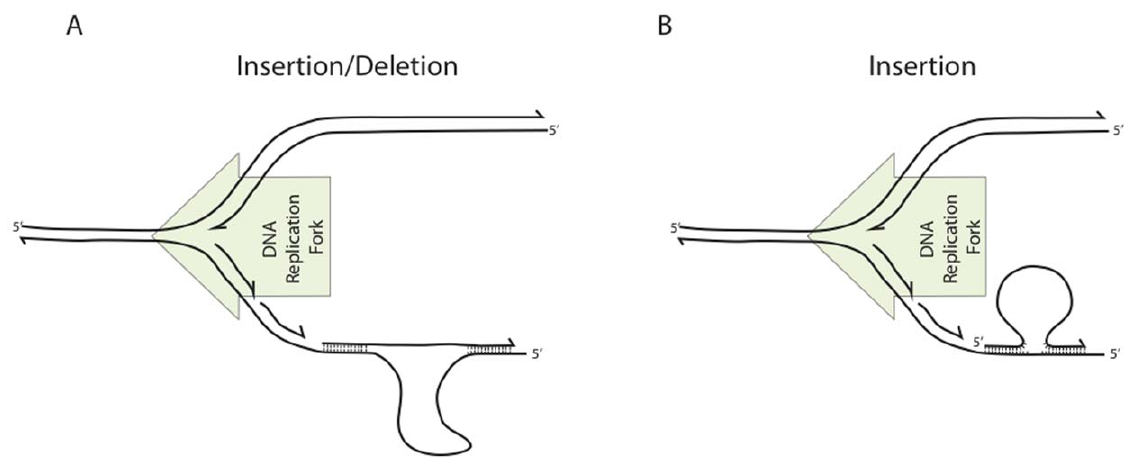
Figure 6. Models of target-substrate structures. (A) When the segment of the target molecule being deleted is larger than the segment being inserted, the target must bend to permit target-substrate annealing. For short insertions, this reaction has higher recombination efficiency, suggesting that the genome more easily adopts a favorable structure. (B) When a recombineering substrate directs an insertion without concomitant deletion, the substrate must bend to achieve target-substrate annealing. The flexibility of the substrate is likely to influence the stability of recombineering heteroduplex intermediate. The green arrow indicates the direction of DNA replication fork movement.